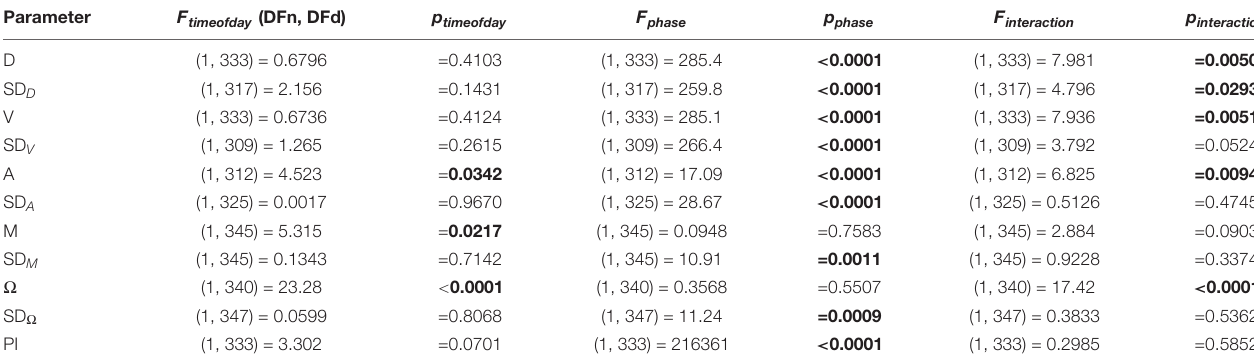
TABLE 3 | Statistical details for Repeated Measure (RM) Two-Way ANOVA with Geisser-Grenhouse Corrections.